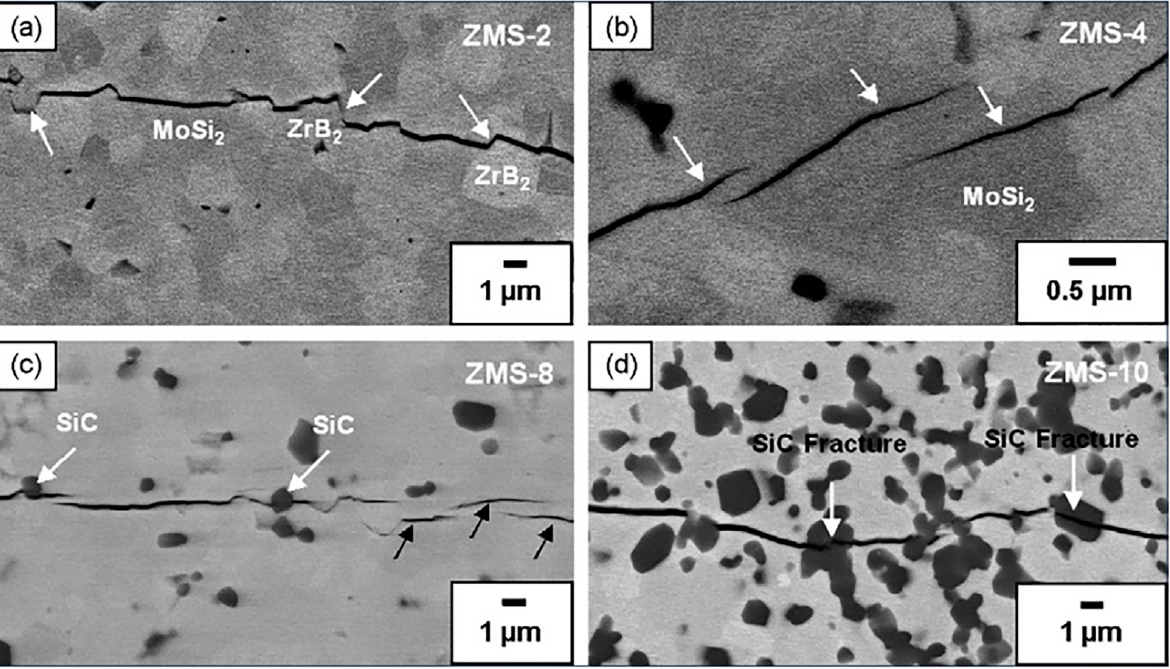
Figure 8. Typical cracking behavior of ZrB 2 -MoSi 2 -SiC composites with different compositions: ( a ) ZMS-2; ( b ) ZMS-4; ( c ) ZMS-8; ( d ) ZMS-10 [101].